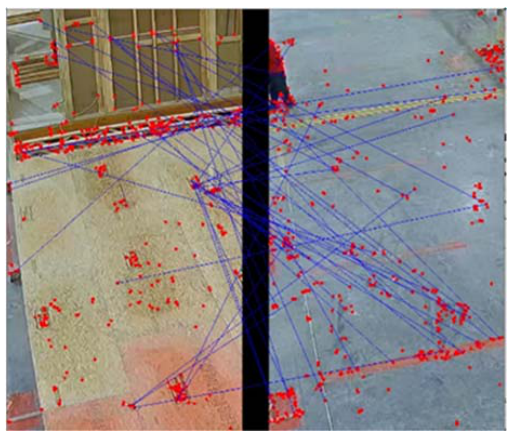
Figure 16. Matching the query frame, on the left, with the ‘empty’ ground truth on the right.